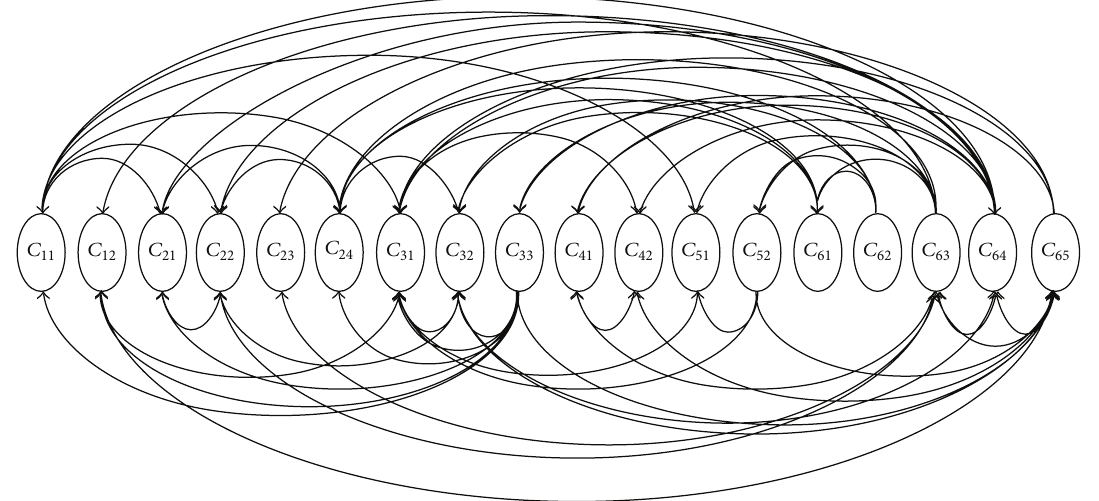
Figure 5: Interdependence subcriteria of research model.